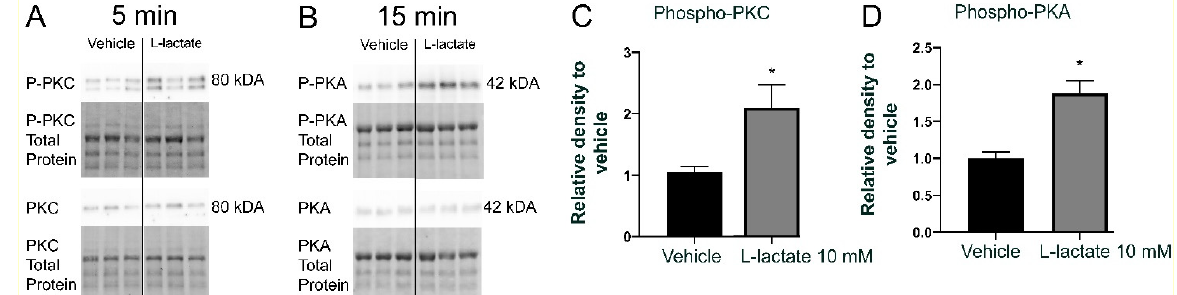
Figure 4. L-lactate increases PKC and PKA phosphorylation ( A , B ) Protein expression levels of P-PKC, PKC, P-PKA, PKA, and total proteins in primary neuron cultures incubated with L-lactate (10 mM) at 37 °C for five min (for PKC) and 15 min (for PKA). The total protein Western blots confirmed equal loading in all lanes with TGX Stain-Free Technology. ( C , D ) Values of relative density to vehicule are presented as the means ± SEM ( C ) for P-PKC and ( D ) for P-PKA. * Indicates significant changes compared to the control group, as compared by the nonparametric ANOVA Krustal Wallis ( p < 0.05) with Dunn’s post hoc correction.